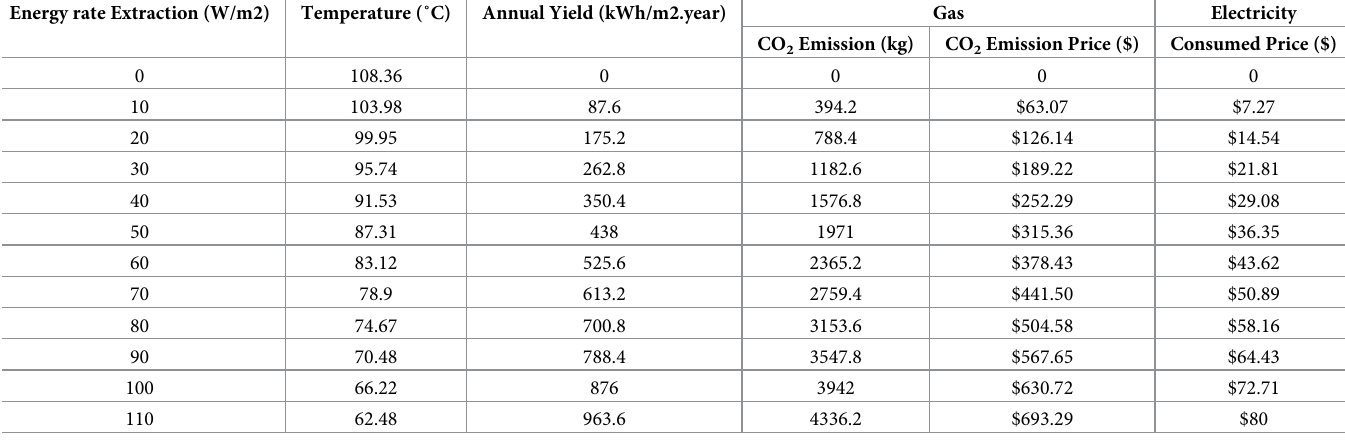
Table 3. Analysis of saving costs of gas and electricity of domestic usage against annual yield of solar pond. Energy rate Extraction (W/m2) Temperature (˚C) Annual Yield (kWh/m2.year)